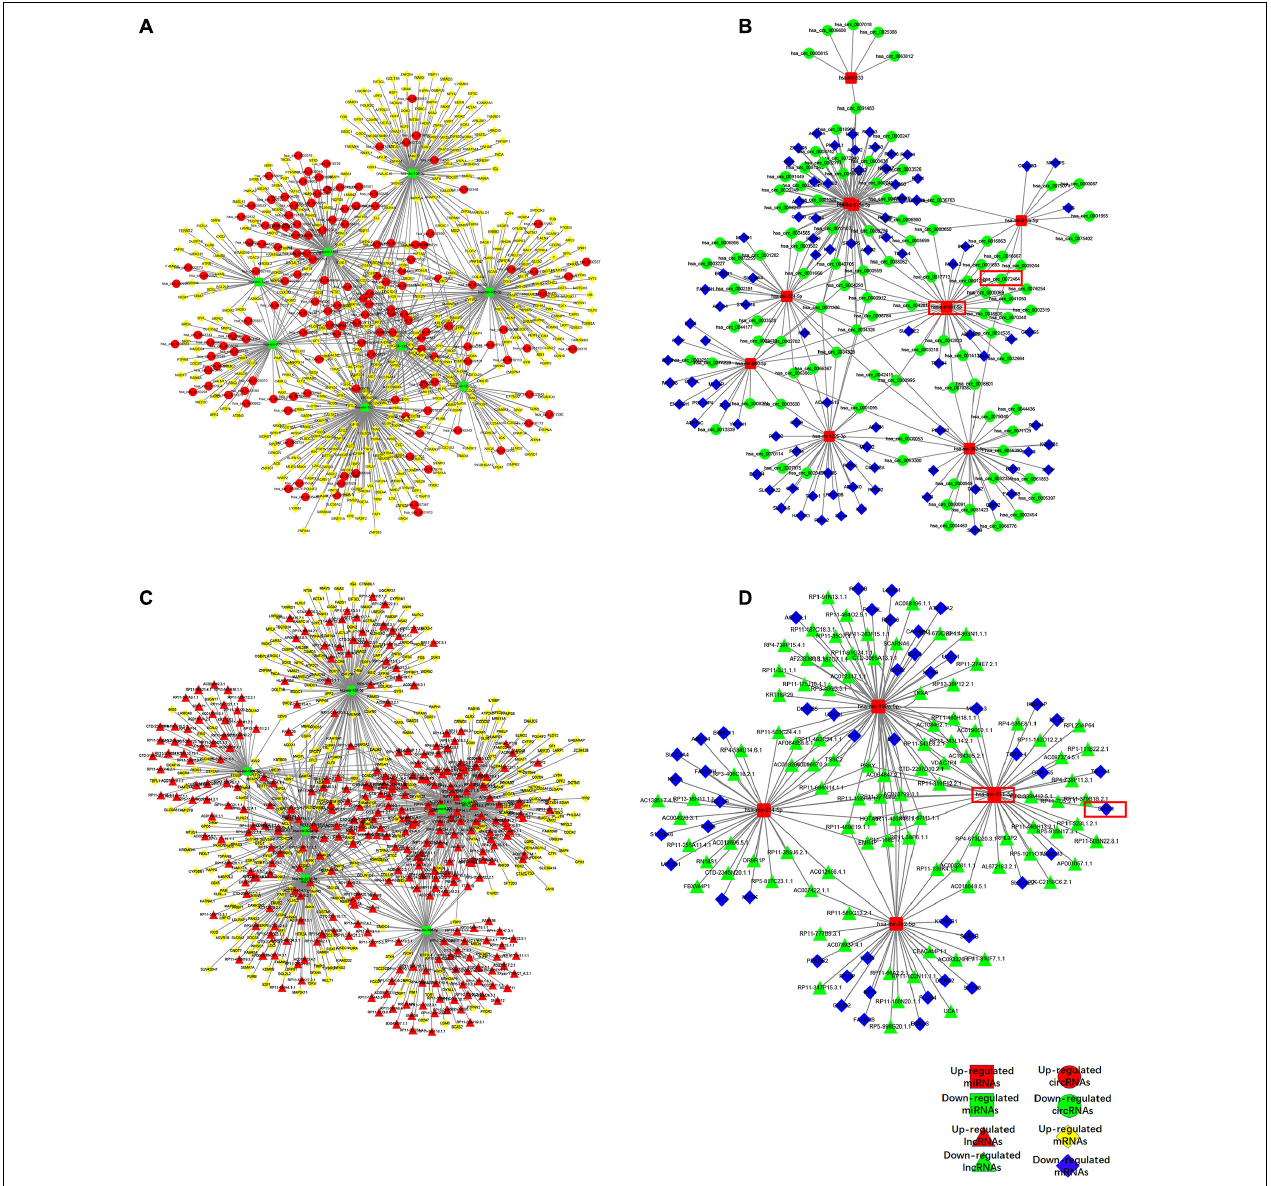
FIGURE 2 | Competing endogenous RNA network in IDD. (A,B) The ceRNA network of down-regulated (A) or up-regulated (B) miRNA with circRNA and mRNA. (C,D) The ceRNA network of down-regulated (C) or up-regulated (D) miRNA with lncRNA and